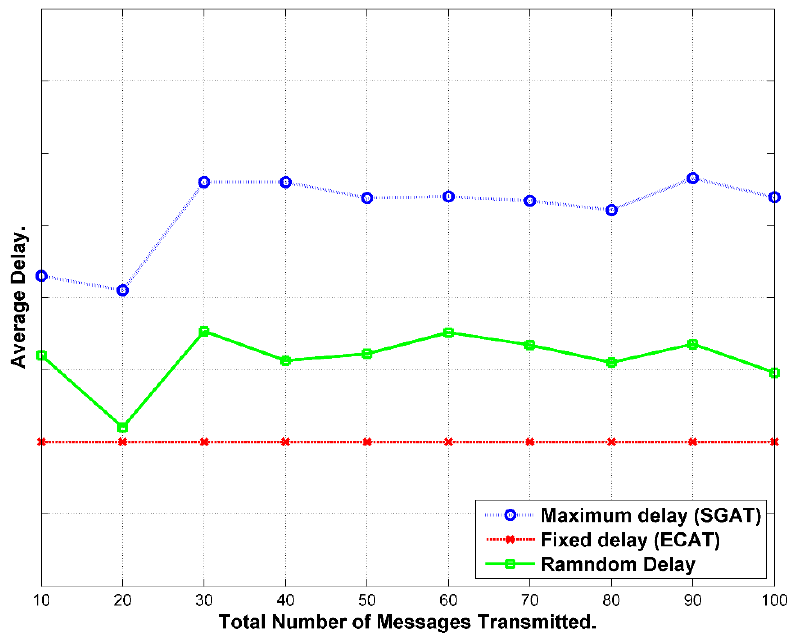
Figure 22. Average accumulated delay per one node. ECAT shows the good performance of a minimum average delay since it sends the message only one subinterval after the message arrival.